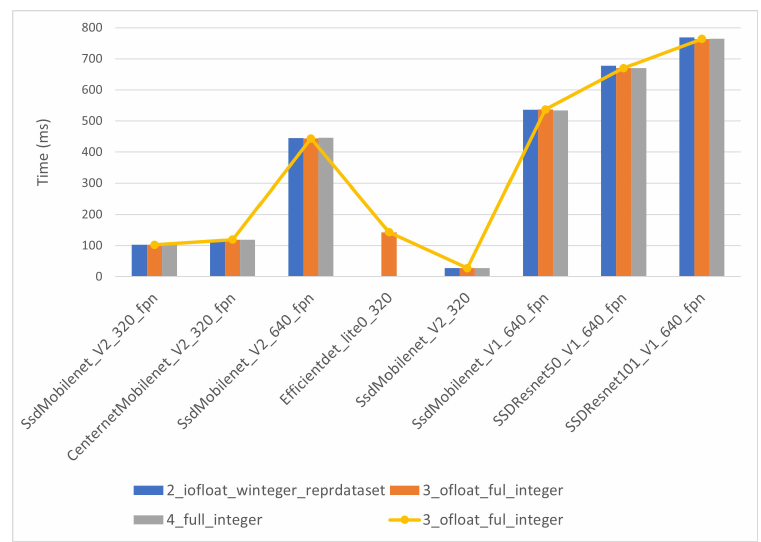
Figure 17. i-MX8M-PLUS inference for co-processor models.